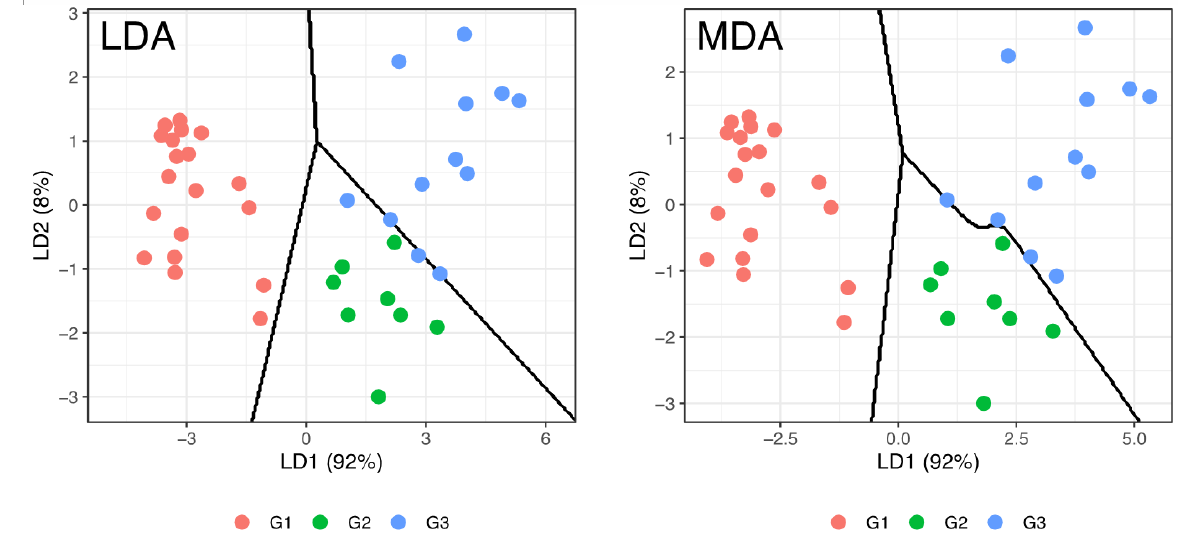
Figure 3. Representation of LDA and MDA discrimination of the samples grouped semi-quantitatively by the percentage of intramuscular fat and the boundary lines separating the zones defined for each group’s discrimination in the bi-dimensional space defined by the two linear discriminant functions. LDA—linear discriminant analysis; MDA—mixture discriminant analysis; LD1—first linear discriminant function; LD2—second linear discriminant function; IMF%—percentage of intramuscular fat; G1—IMF% group 1, 0.6 to 1.1% (central value, 0.85%); G2—IMF% group 2, 1.25 to 1.5% (central value, 1.38%); G3—IMF% group 3, comprising values greater than 1.5% (central value, 1.79%).